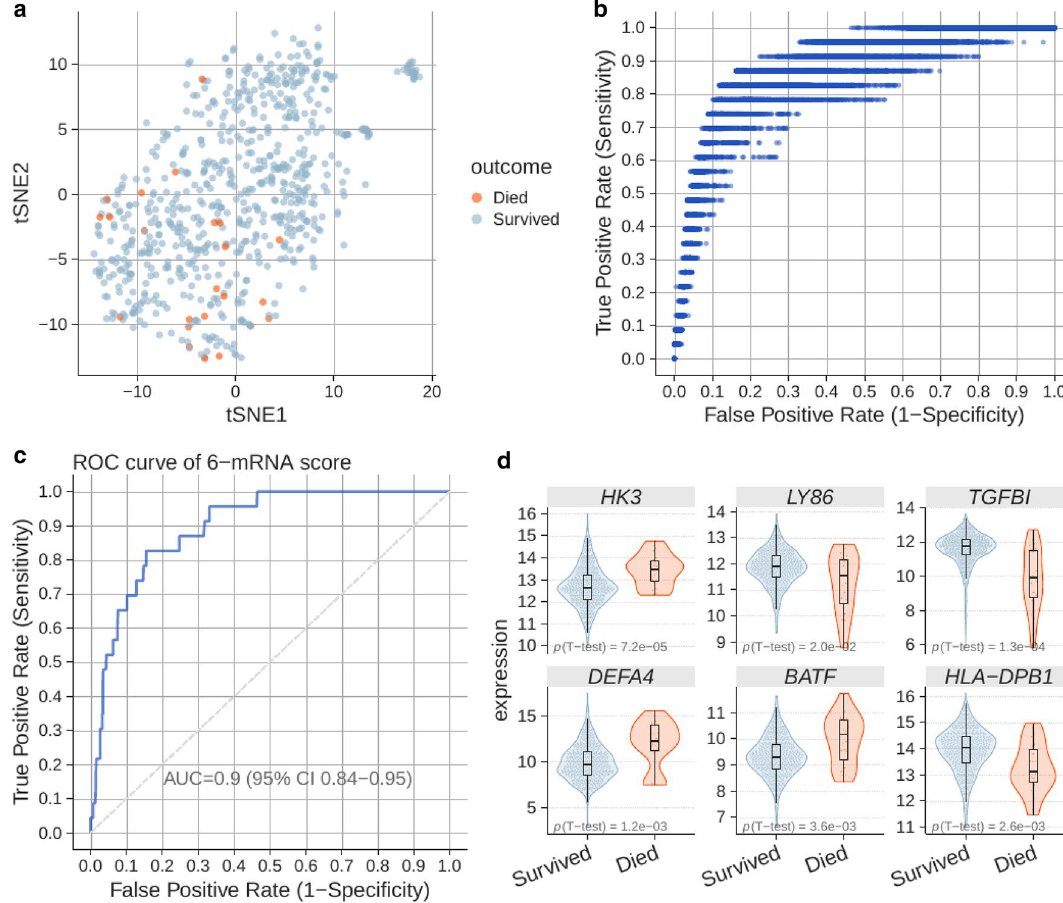
Figure 2. Training data for the 6-mRNA classifier. ( a ) Visualization of 705 samples across 21 studies in low dimension using t-SNE. ( b ) Logistic regression model selection. Each dot corresponds to a model defined by a combination of logistic regression hyperparameters and a decision threshold. Entire search space (100 hyperparameter configurations) is shown. ( c ) ROC plot for the best model. The plot is constructed using pooled probabilities from cross-validation folds. ( d ) Expression of the 6 genes used in the logistic regression model according to mortality